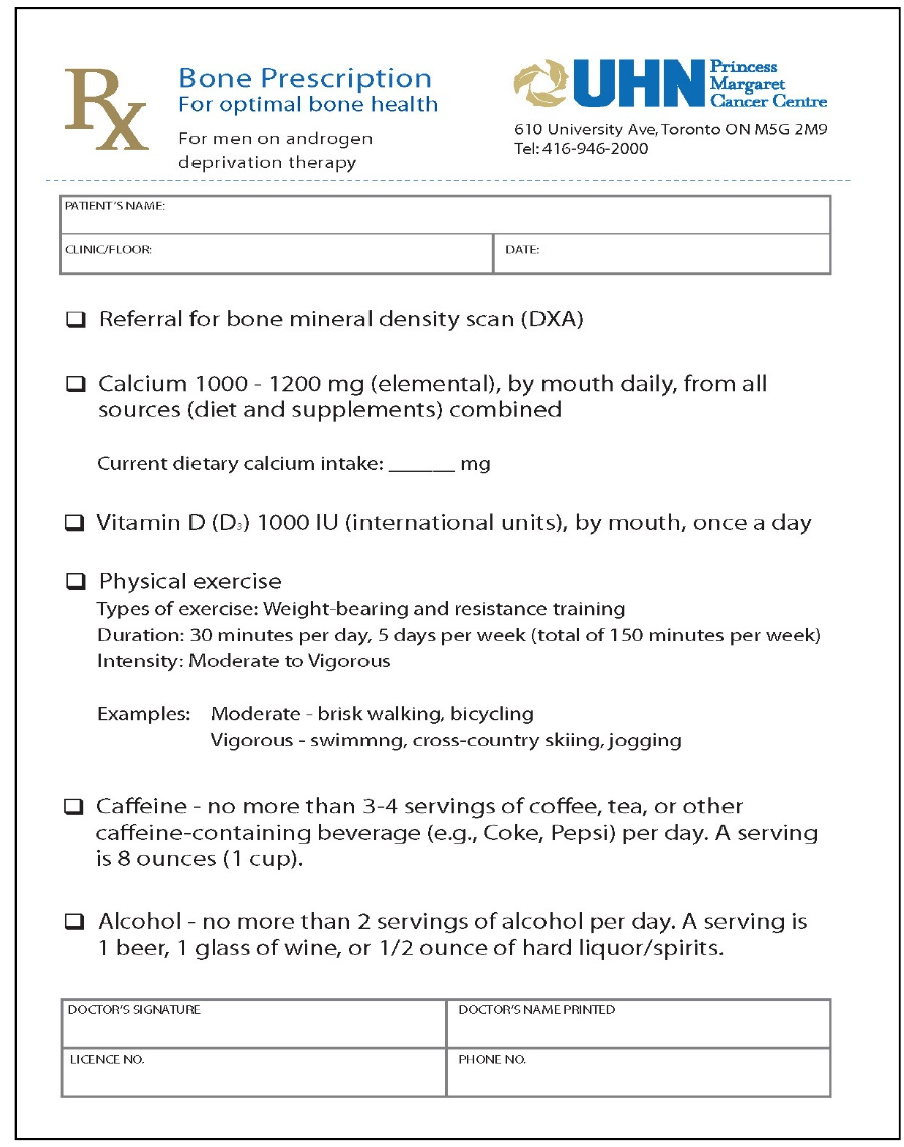
Figure 1. BoneRx Healthy Bone Prescription.